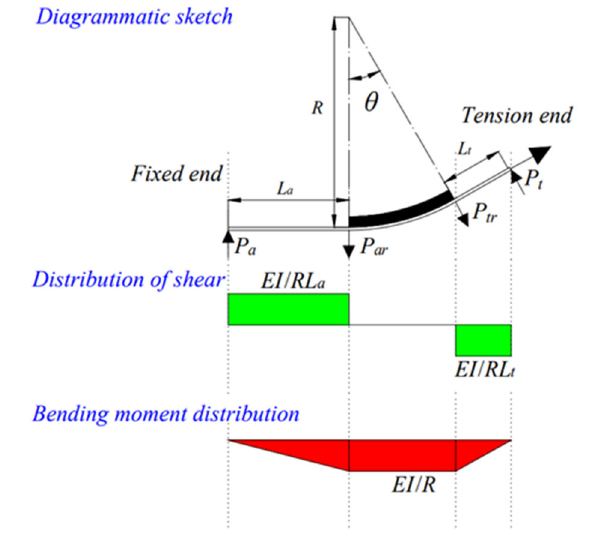
Figure 11. Sketch of the one bending calculation.